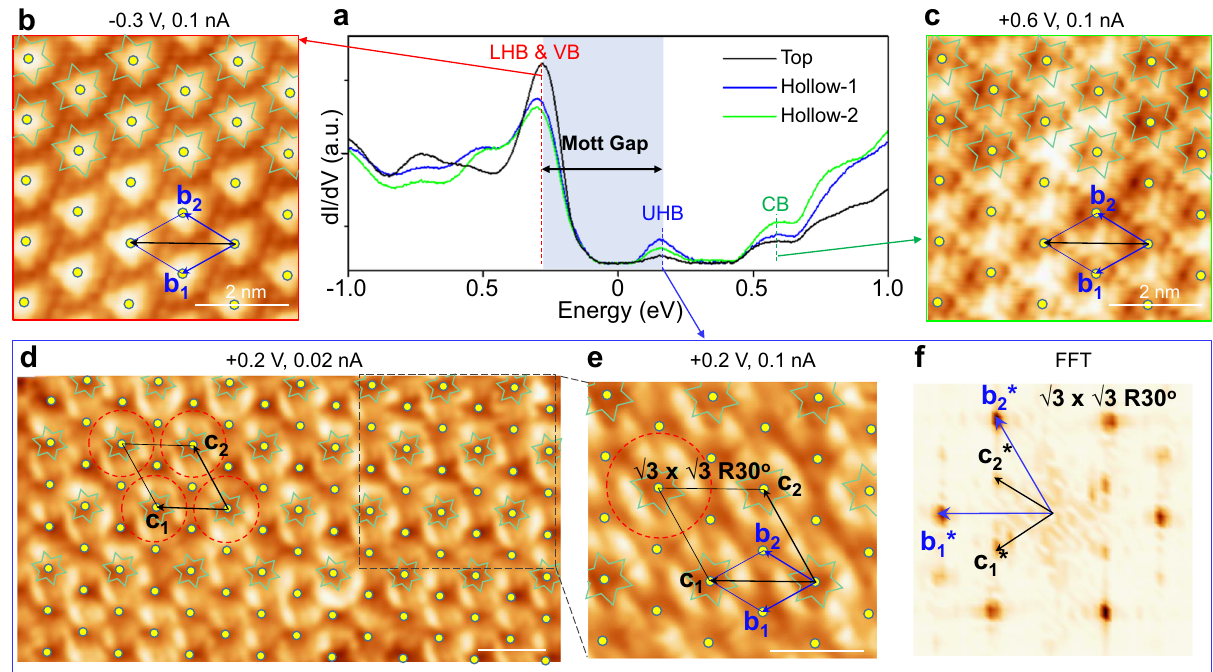
Fig. 3 Intriguing spatial dependence of UHB. a d I /d V spectra captured at Top, Hollow-1, and Hollow-2 areas of 1T-NbSe 2 . b , c STM images of SL 1T-NbSe 2 at − 0.3 and + 0.6 V, respectively. d , e STM images captured with 0.2 V, 0.02 nA, and 0.2 V, 0.1 nA, respectively, showing √ 3 × √ 3 R30° superstructure (with unit vectors c 1 and c 2 ) with respect to the CDW pattern (with unit vectors b 1 and b 2 ). f Corresponding FFT of e . Tunneling parameters: a − 1 V, 0.02 nA before turning off feedback loop. Scale bar for b – e : 2 two “ fl owers ” centered at the long diagonal axis were brighter, whereas the two centered at the short diagonal axis were dim. Thus, in the hexagonal lattice of the SOD pattern, one bright fl ower is surrounded by six dim fl owers as nearest neighbors. This